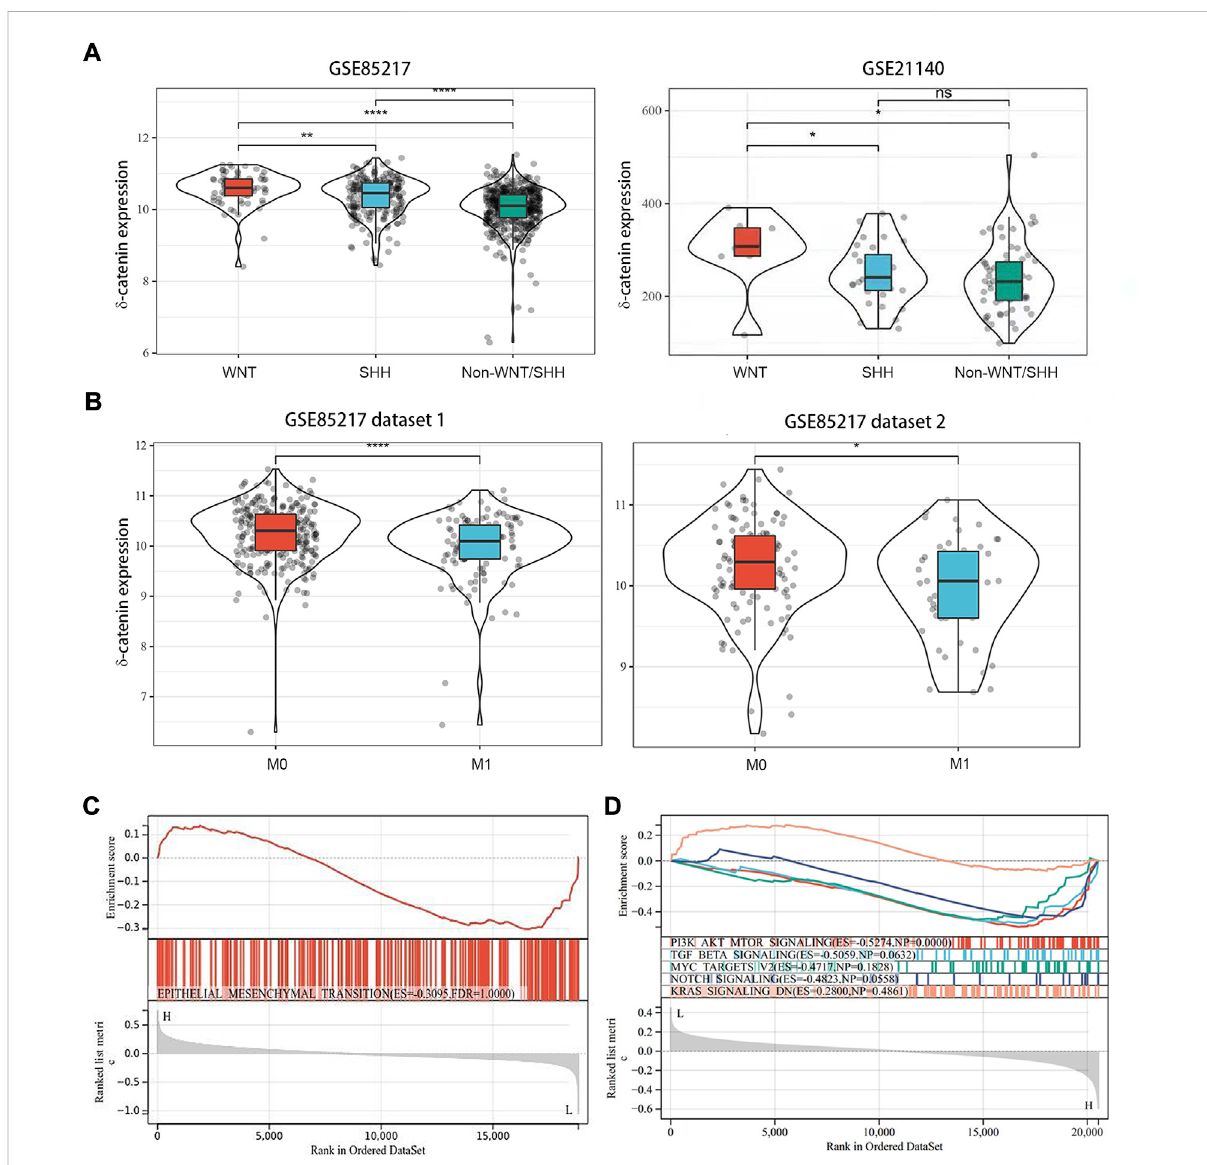
FIGURE 3 Delta-catenin expression in the medulloblastoma molecular subgroups, and its effects on metastasis. (A) Delta-catenin expression by medulloblastoma subgroup: delta-catenin was enriched in WNT subgroup. Data obtained from three nonoverlapping cohorts. SHH: sonic hedgehog; WNT: wingless. (B) Delta-catenin mRNA expression in tumor samples from non-metastatic and metastatic tumors. Delta-catenin expression is signi fi cantly higher in non-metastatic than in metastatic samples (Student ’ s t -test). (C) GSEA of genes whose expression is downregulated by delta-catenin reveals the over-representation of EMT-signaling-related genes. (D) GSEA analysis showed that the metastasis- related signaling pathways such as PI3K/AKT, TGF-beta and so on were highly enriched in the low delta-catenin expression